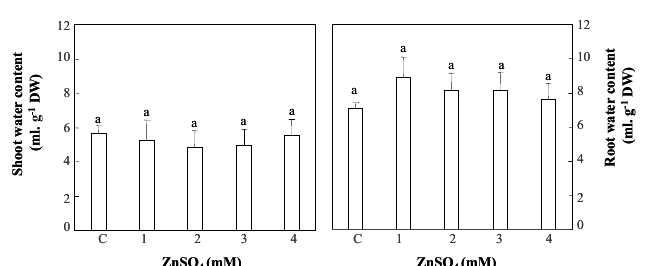
Fig. 2: Shoot and root water content of fenugreek plants grown with dif- ferent ZnSO 4 concentrations for 52 days. Values (means ± SE of five replicates) followed by the same letter are not significantly different (Duncan test, P = 0.05).